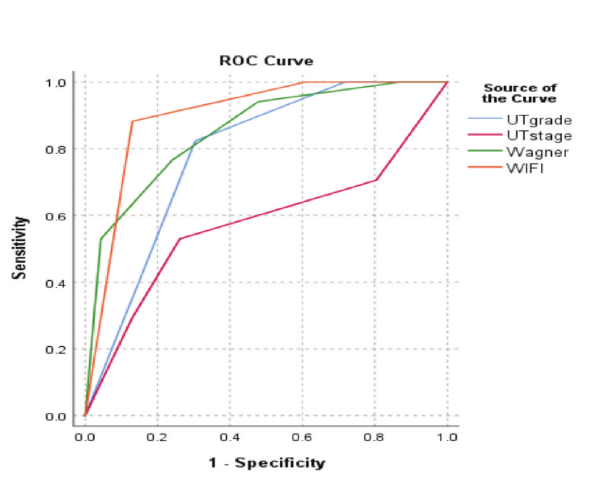
Receiver Operating Characteristic (ROC) curves of the Fig. 3: three classification